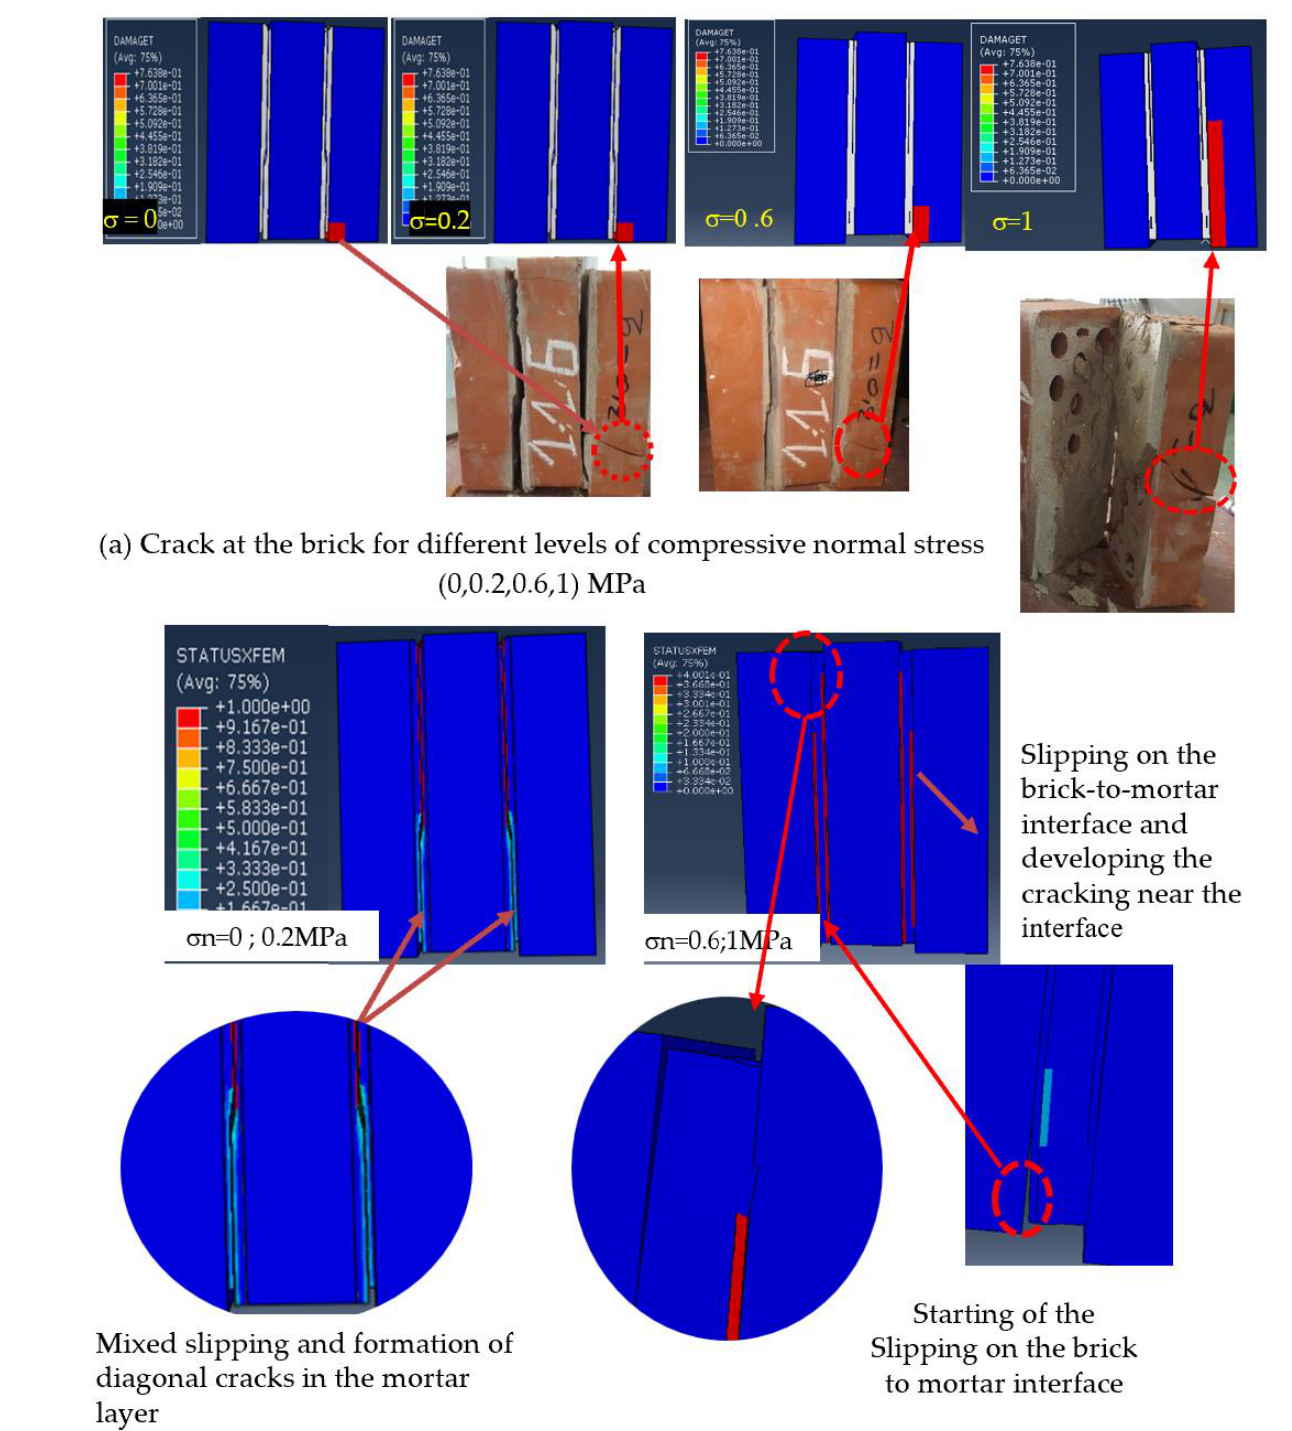
Figure 10. Failure mechanisms of unreinforced masonry shear triplets under different levels of pre- compression obtained from experimental tests and the numerical model ( a ) for brick; ( b ) for mortar.